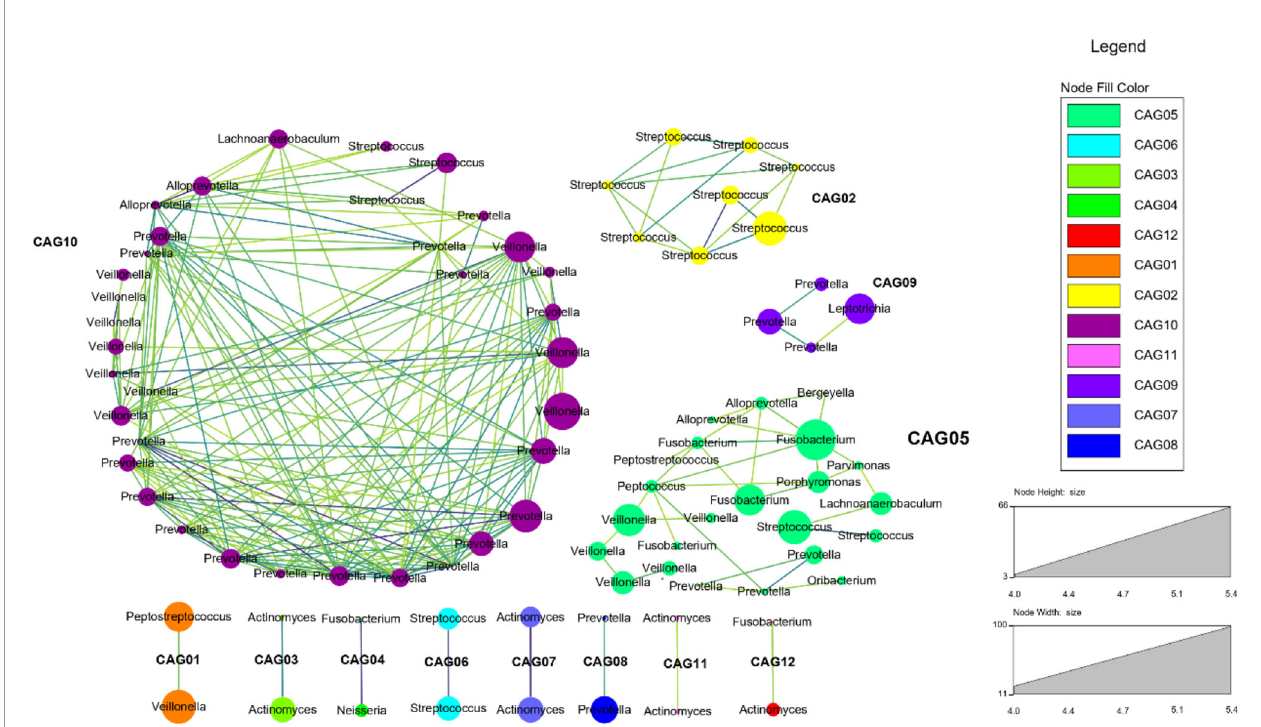
FIGURE 4 | The co-abundance network of the tongue coating microbiota (at the genus level, different dot colors in the fi gure represent different modules, the larger the circle, the higher the abundance; the darker the color of the connecting line between the modules, the higher the